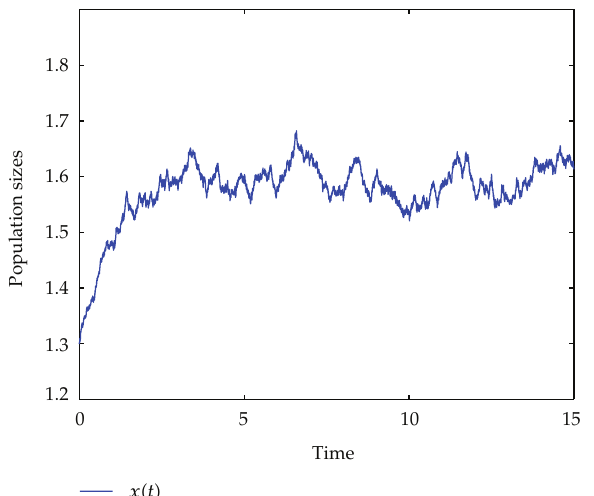
Figure 4: Seen from the two-dimensional spaces, the population x (cid:3) t (cid:4) will be stochastic permanent, step size Δ t (cid:5) 0 . 001 and x (cid:3) 0 (cid:4) (cid:5) 1 . 3.